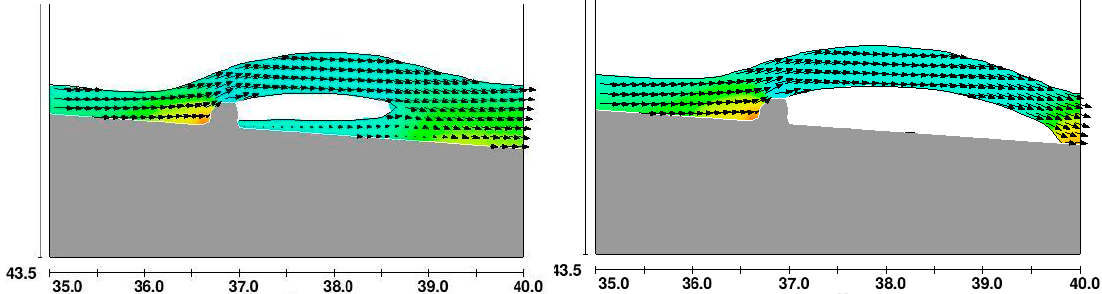
Figure 8. Influence of air entraiment module on numerical results.